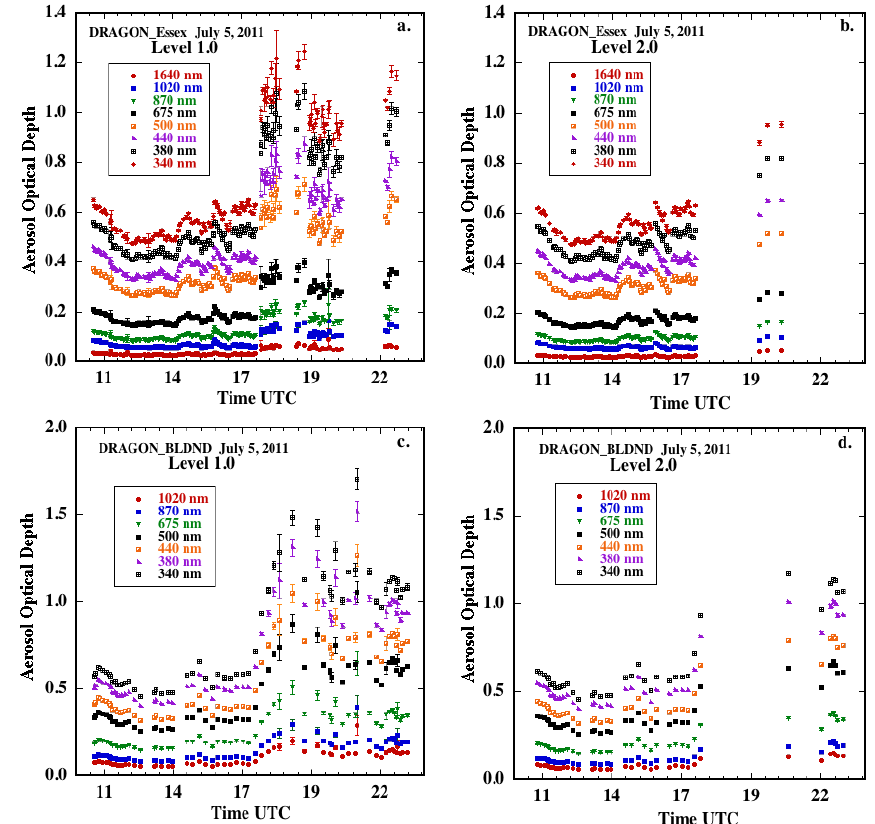
Figure 16. Examples of non-cloud-screened (Level 1) vs. Level 2 Version 2 cloud screened AOD time series for the DRAGON_Essex (a) and (b) and DRAGON_BLDND sites (c) and (d) in Maryland on 5 July